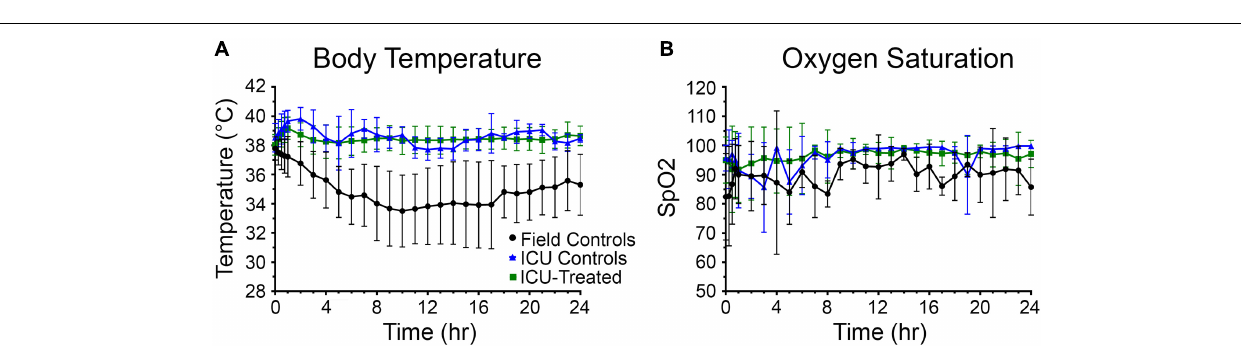
FIGURE 3 | Body temperature and oxygen saturation for rats in each treatment group over 24 h. (A) Rats that received thermal support in the ICU environment following nerve agent (NA) exposure were better able to maintain body temperature than field controls. A mixed-effects analysis with Tukey’s multiple comparison test showed that body temperature of field control rats ( n = 28) differed significantly from ICU controls ( n = 16) and ICU-treated rats ( n = 132) at all time points except for 15 min ( p < 0.05). (B) Supplemental oxygen in the ICU environment allowed rats to maintain oxygen saturations > 95% for the majority of the study. Though a mixed-effects analysis with Tukey’s multiple comparison test showed that SpO 2 levels of field control rats ( n = 12) did not differ significantly from ICU controls ( n = 11) or ICU-treated rats ( n = 80), mean SpO 2 values for the field control group fluctuated greatly throughout the study. For both panels, data points show means for each treatment group, and error bars indicate standard